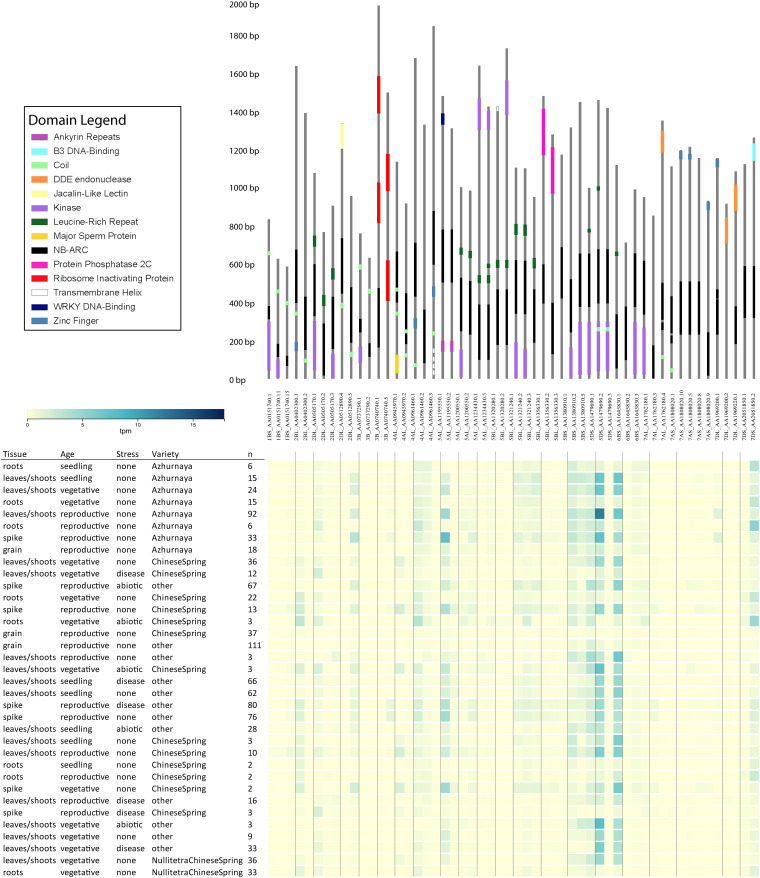
Alternative transcripts of wheat NLR-ID genes in which IDs were excluded or truncated in at least one alternative transcript. Upper panel shows the gene models of the NLR-ID genes. Domains are color-coded as defined in the domain legend. Wheat accession names include information on chromosome arm, accession number, and transcript number. Below the gene models are expression data from the Wheat Gene Expression Atlas, showing that these alternative transcripts can be experimentally tested for their expression in wheat tissues. The expression of these transcripts varies by variety, type of stress, and tissue type. Visualization layout was made based upon expVIP within the Wheat Gene Expression Atlas database.